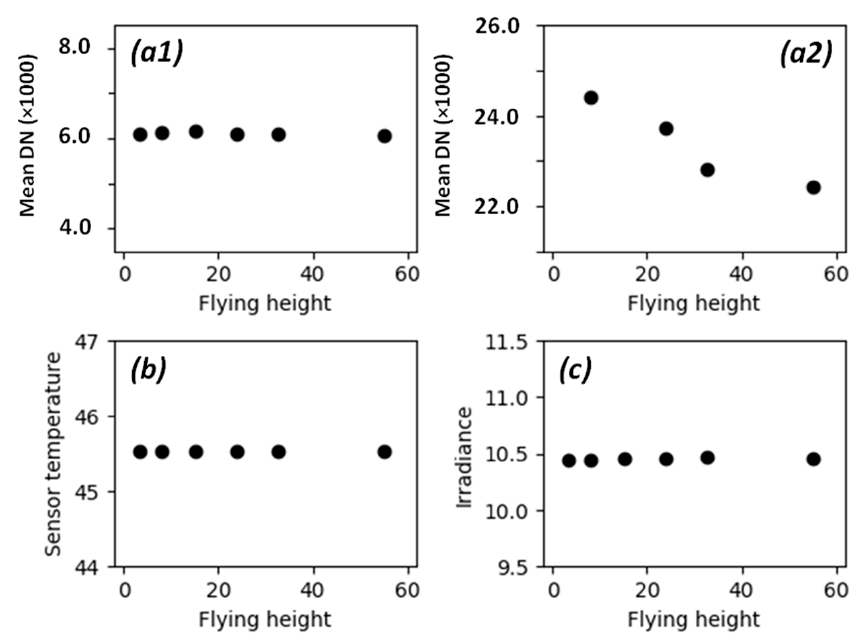
Figure 14. Mean pixel values for the red band over the 5% ( a1 ) and the 20% ( a2 ) reflectance calibration panels during the flight on 20 May 2019. The low number of observations for the 20% panel was due to saturation in some images. Images were captured while descending over the panels with stable camera temperature ( b ) and irradiance ( c ).